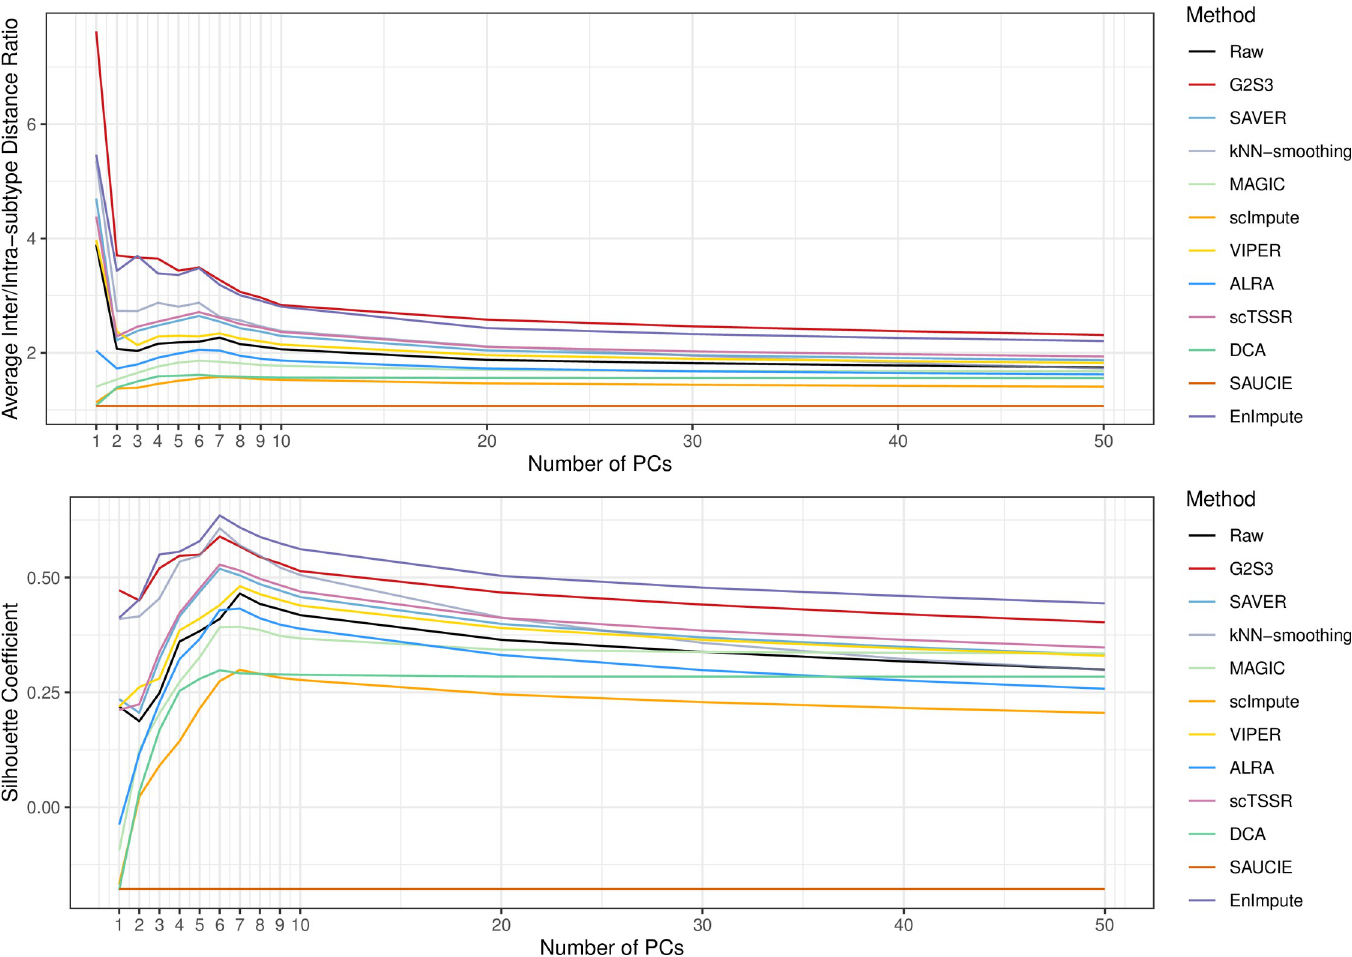
Fig 2. Evaluation of G2S3 in improving cell subtype separation. Average inter/intra-subtype distance ratio (top) and silhouette coefficient (bottom) to demonstrate cell subtype separation using the top principal components of the raw unimputed and imputed data by each method in the Chu dataset.